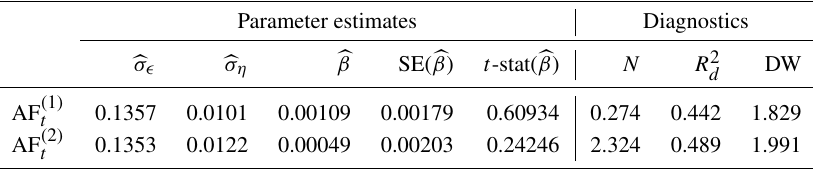
Table 1. Univariate analysis of the airborne fraction.